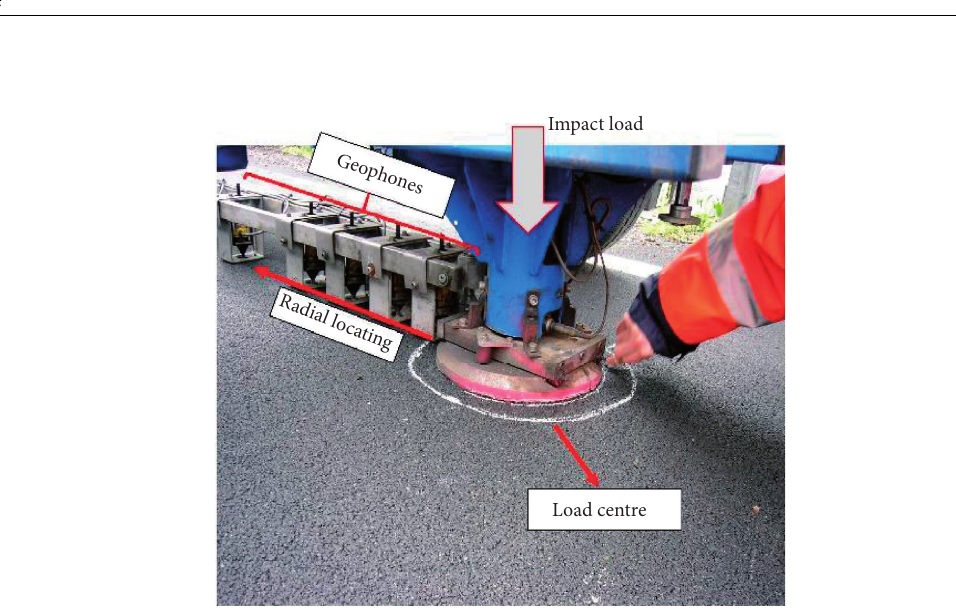
Figure 2: Experimental test of FWD.